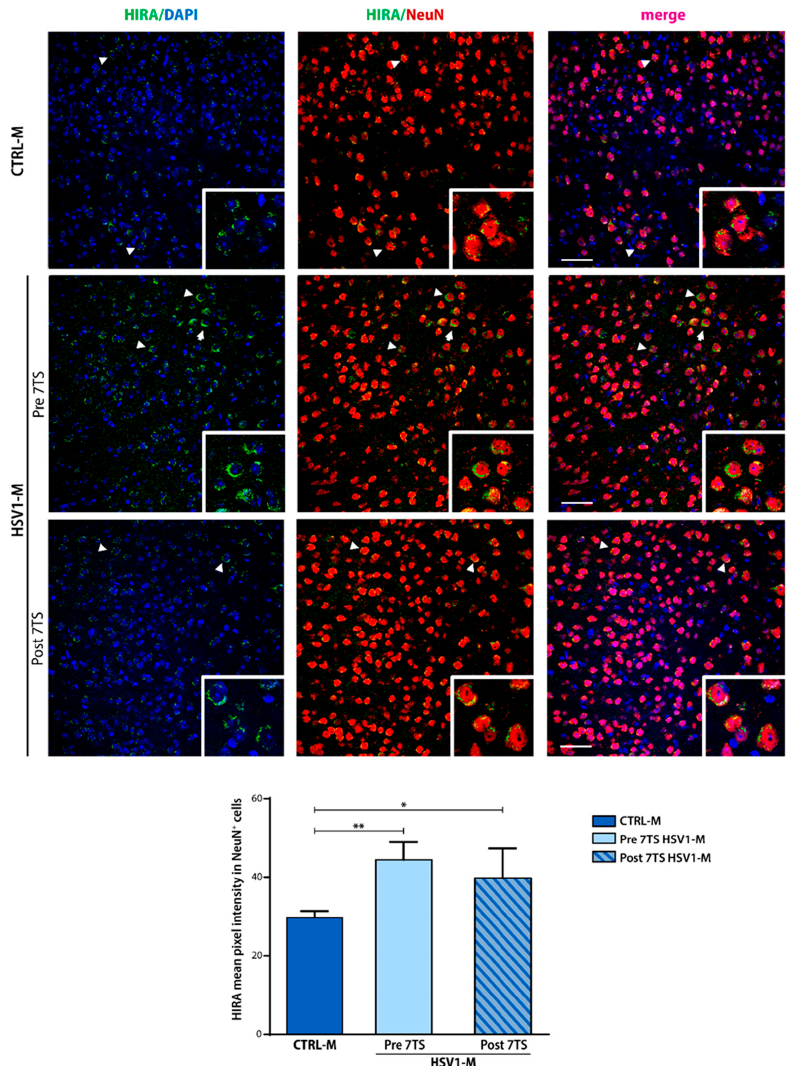
mean fluorescence intensity of neuronal HIRA protein (i.e., detected in NeuN + cells) was found to be significantly increased in Pre 7TS HSV1-M with respect to age-matched control mice (Figure 6; Pre 7TS ** p = 0.004 vs. CTRL-M). Moreover, HIRA seems to be affected by virus reactivation as its intensity was found slightly decreased in Post 7TS HSV1-M tested compared to Pre 7TS mice, although it was significantly higher with respect to matched CTRL-M (Figure 6; Post 7TS * p = 0.02 vs. CTRL-M). Furthermore, the nuclear localization of the protein changed in the infected Pre 7TS where HIRA was distributed perinuclearly in a more extensive way, contrary to CTRL-M, where HIRA was localized in more compact foci. Similarly, this occurred also in the Post 7TS, although the quantity of the protein decreased after reactivation.